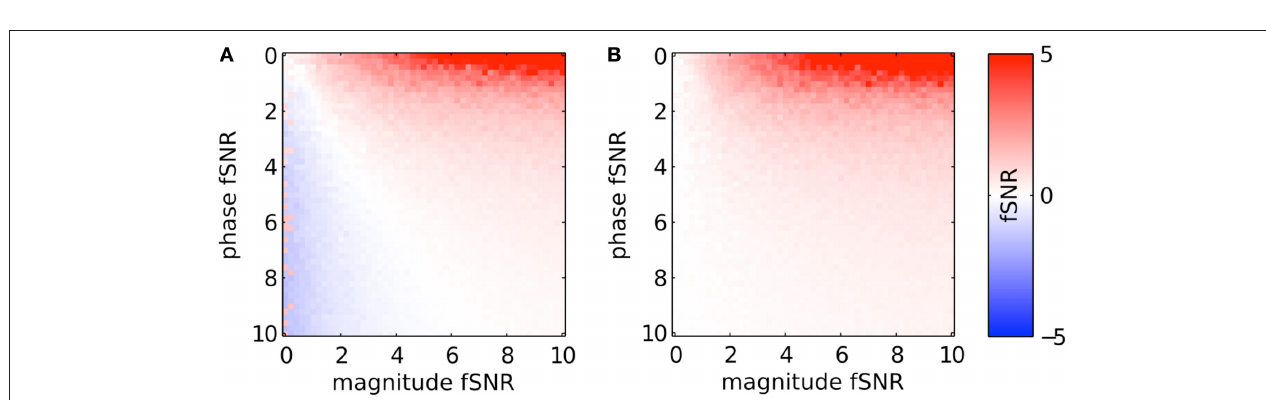
FIGURE 6 | Simulated large vein suppression as a function of phase and magnitude fSNR plotted for (A) PR and (B) sPR. PR overcorrects for large vein contributions. This results in artifactual non-zero t -values at low magnitude fSNRs. sPR does not overcorrect for large vein